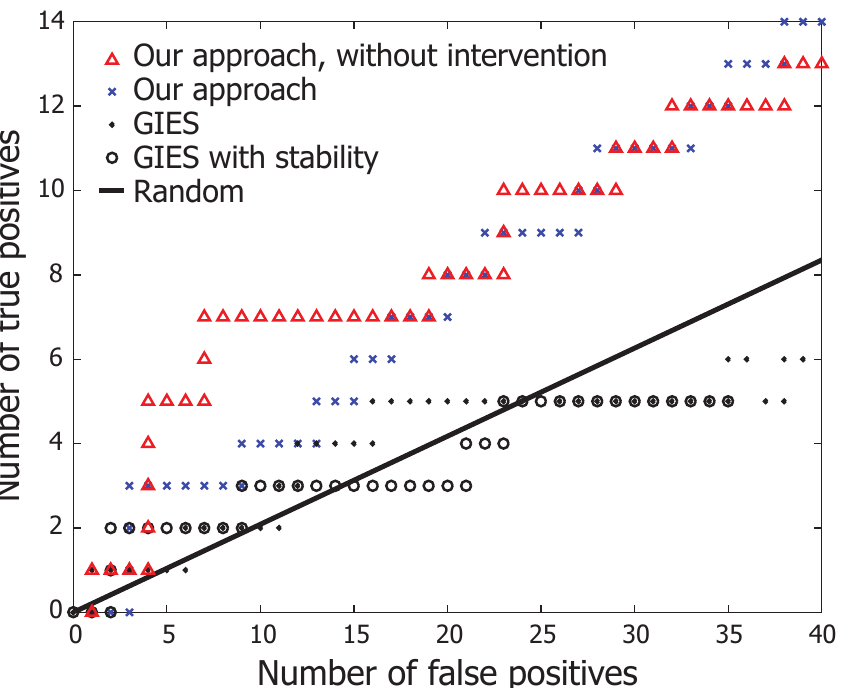
Fig 2. Reconstruction performance on single cell gene expression data. We applied our Bayesian structure learning algorithm based on GBNs to uncover the signaling pathway of 11 human proteins from expression data provided by Sachs et al. [5]. MAP estimates of edge weights calculated using 1,000 posterior graph samples are used to generate a ranked list of (directed) edges for evaluation of accuracy. The data points for GIES are taken from Hauser and Bühlmann [19] for comparison. The result suggests GBNs can uncover causal edges in real biological networks, and that our approach is more effective than GIES.